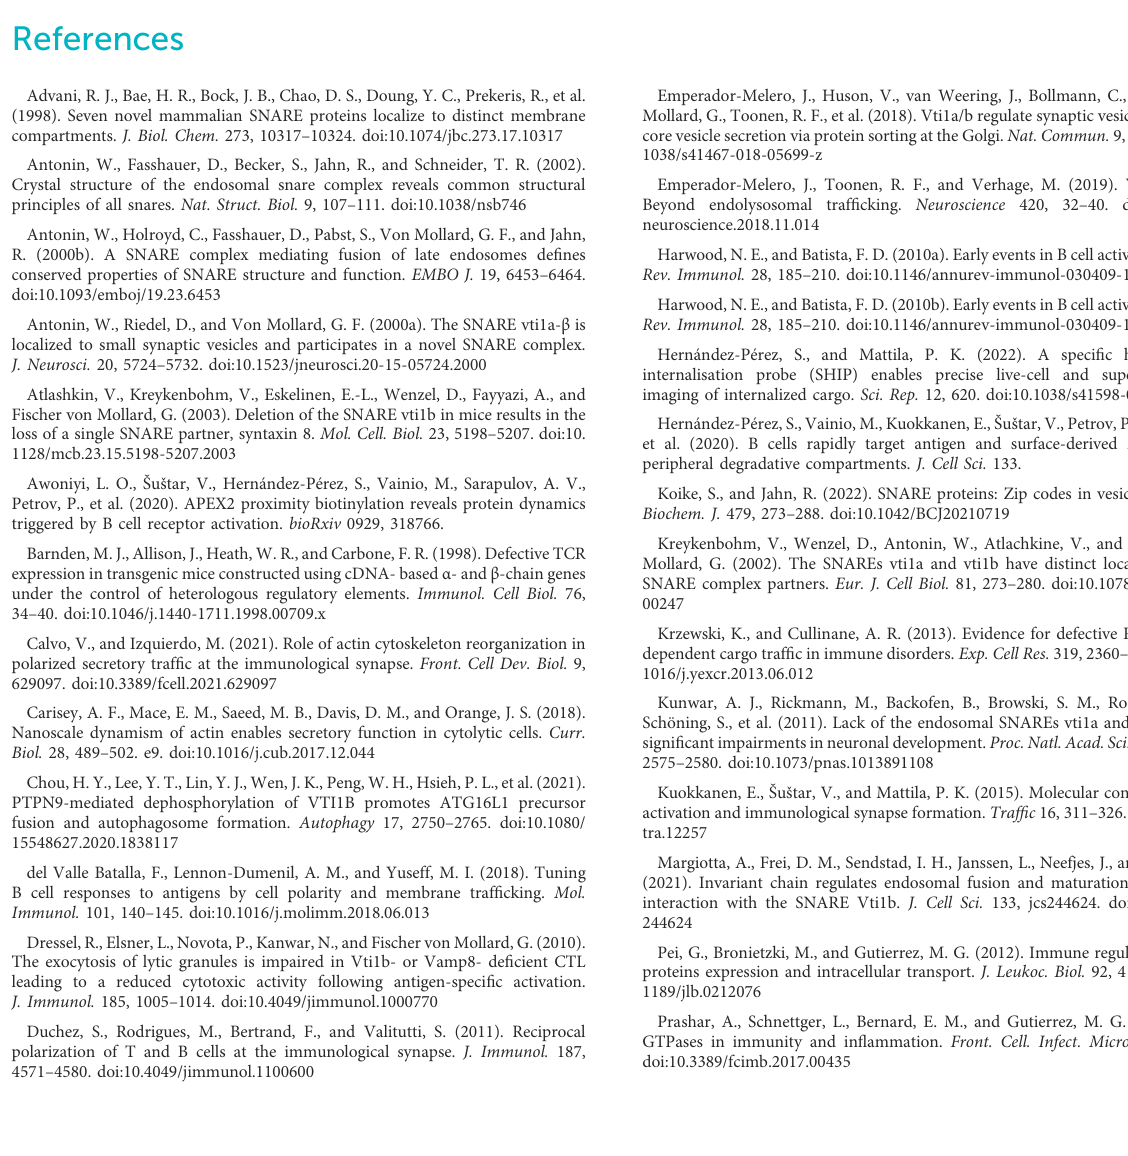
SUPPLEMENTARY TABLE S1 List of antibodies used in the